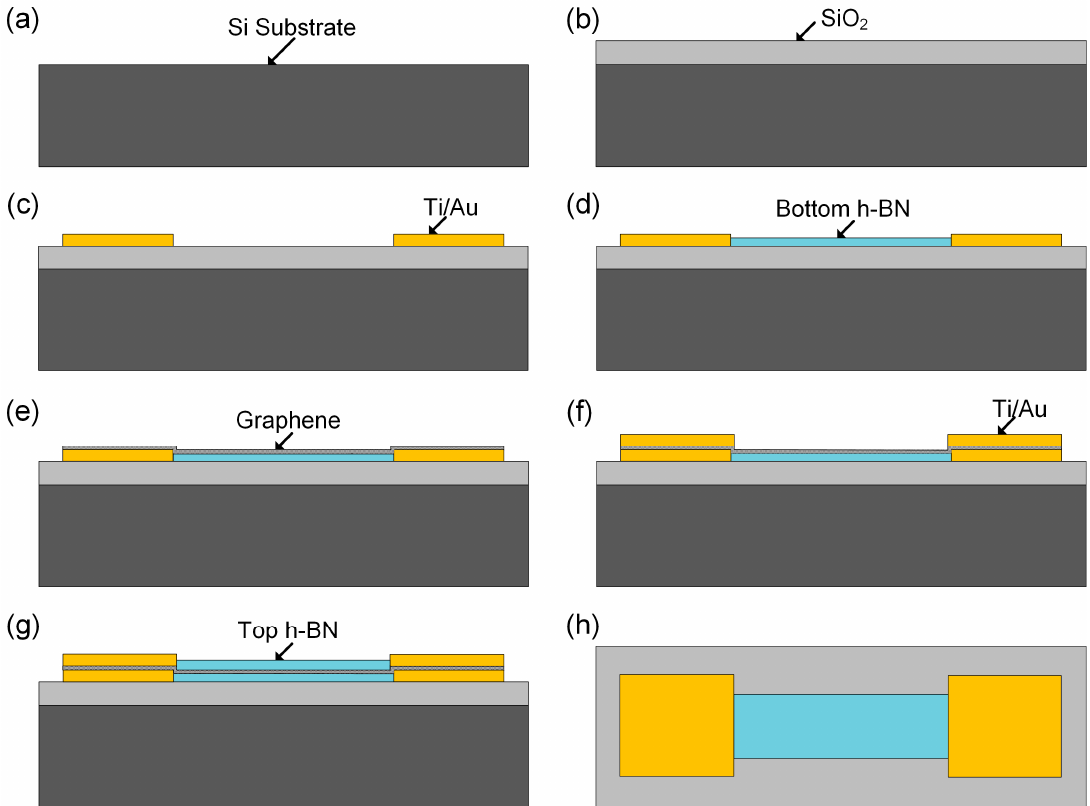
Figure 1. Structure and fabrication process of the sensors: the process flow of the non-cavity-type graphene sensor: ( a ). The silicon substrate is cleaned; ( b ). SiO 2 insulating layer is formed on the surface of the silicon substrate through Plasma Enhanced Chemical Vapor Deposition (PECVD); ( c ). Sputtering of metal, forming a heterogeneous junction bottom electrode; ( d ). The underlying BN is transferred and the graphics of BN are completed; ( e ). Graphene is transferred and its graphics completed; ( f ). The top-level BN is transferred and the graphics of BN are completed; ( g ). The top metal electrode is vaporized; ( h ). Vertical view of the device structure.